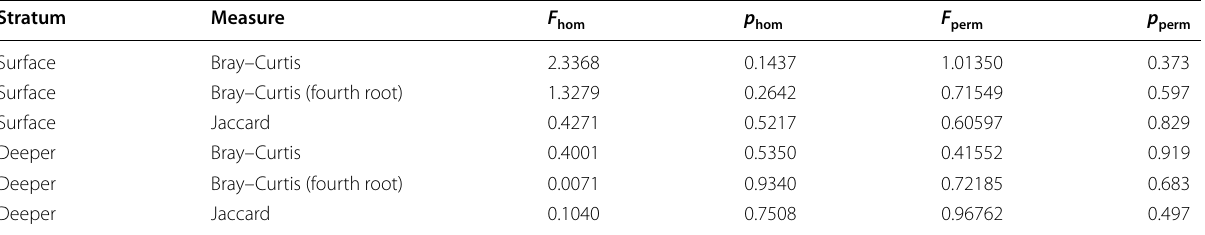
Table 2 Results of the homoscedasticity tests and PERMANOVA to compare zooplankton in the two strata between sites near to and far from aquaculture centers. The resemblance measurements and data transformations are indicated